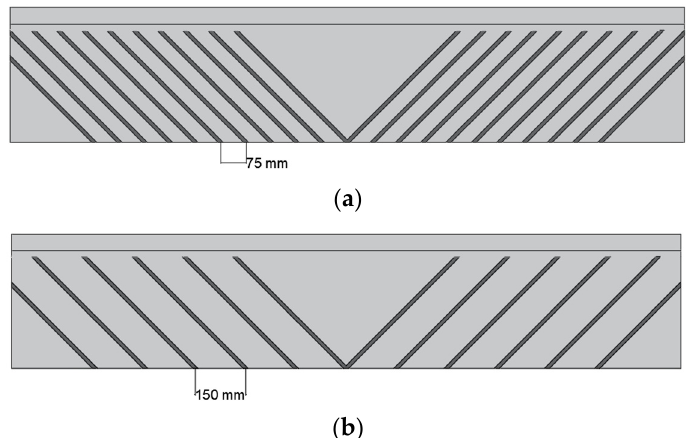
Figure 2. Details of CFRP configurations: ( a ) beams with 75 mm carbon spacing; ( b ) beams with 150 mm carbon spacing.